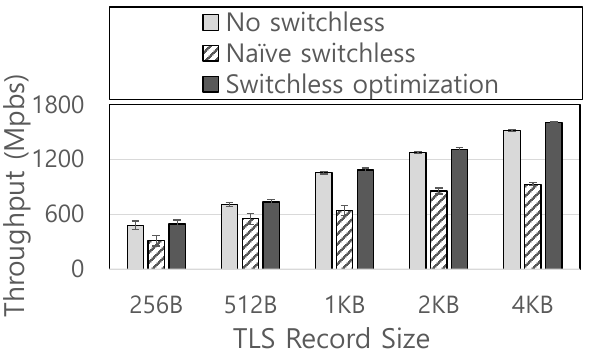
Figure 6. Decryption throughput while varying the TLS record size.